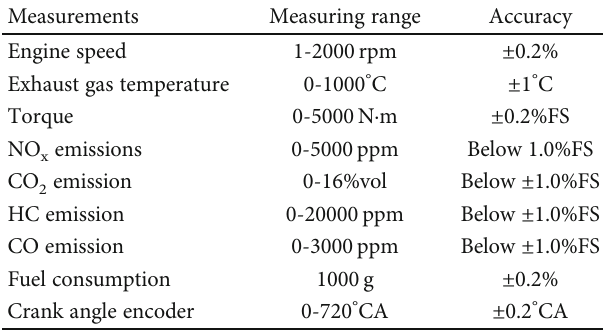
Table 4: List of measurements, the measuring range, and